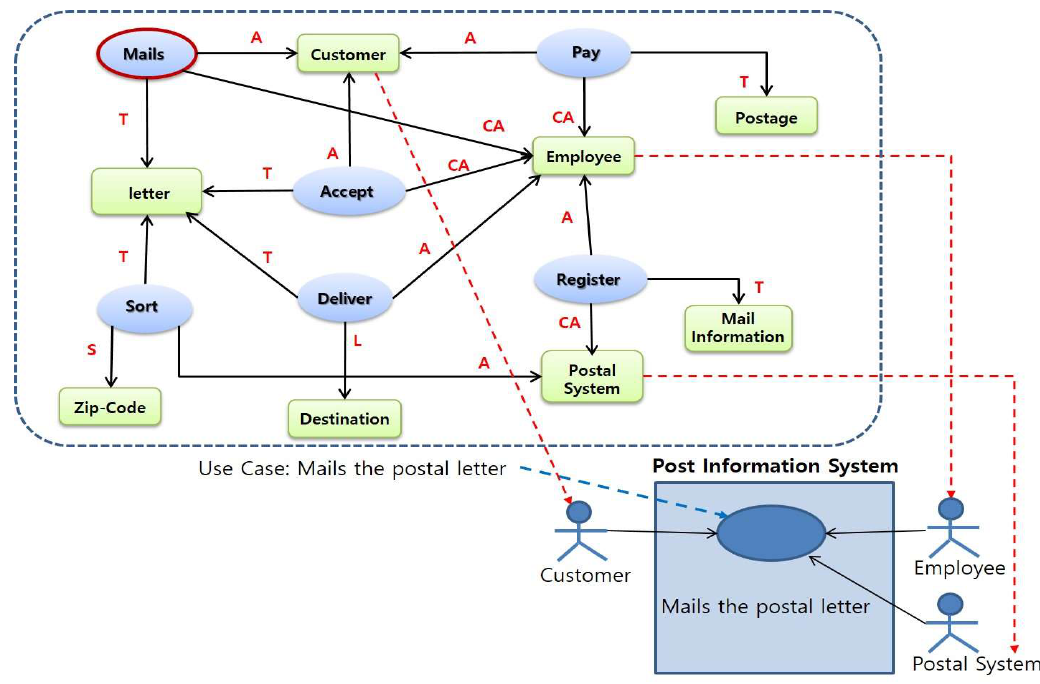
Figure 12. Use case